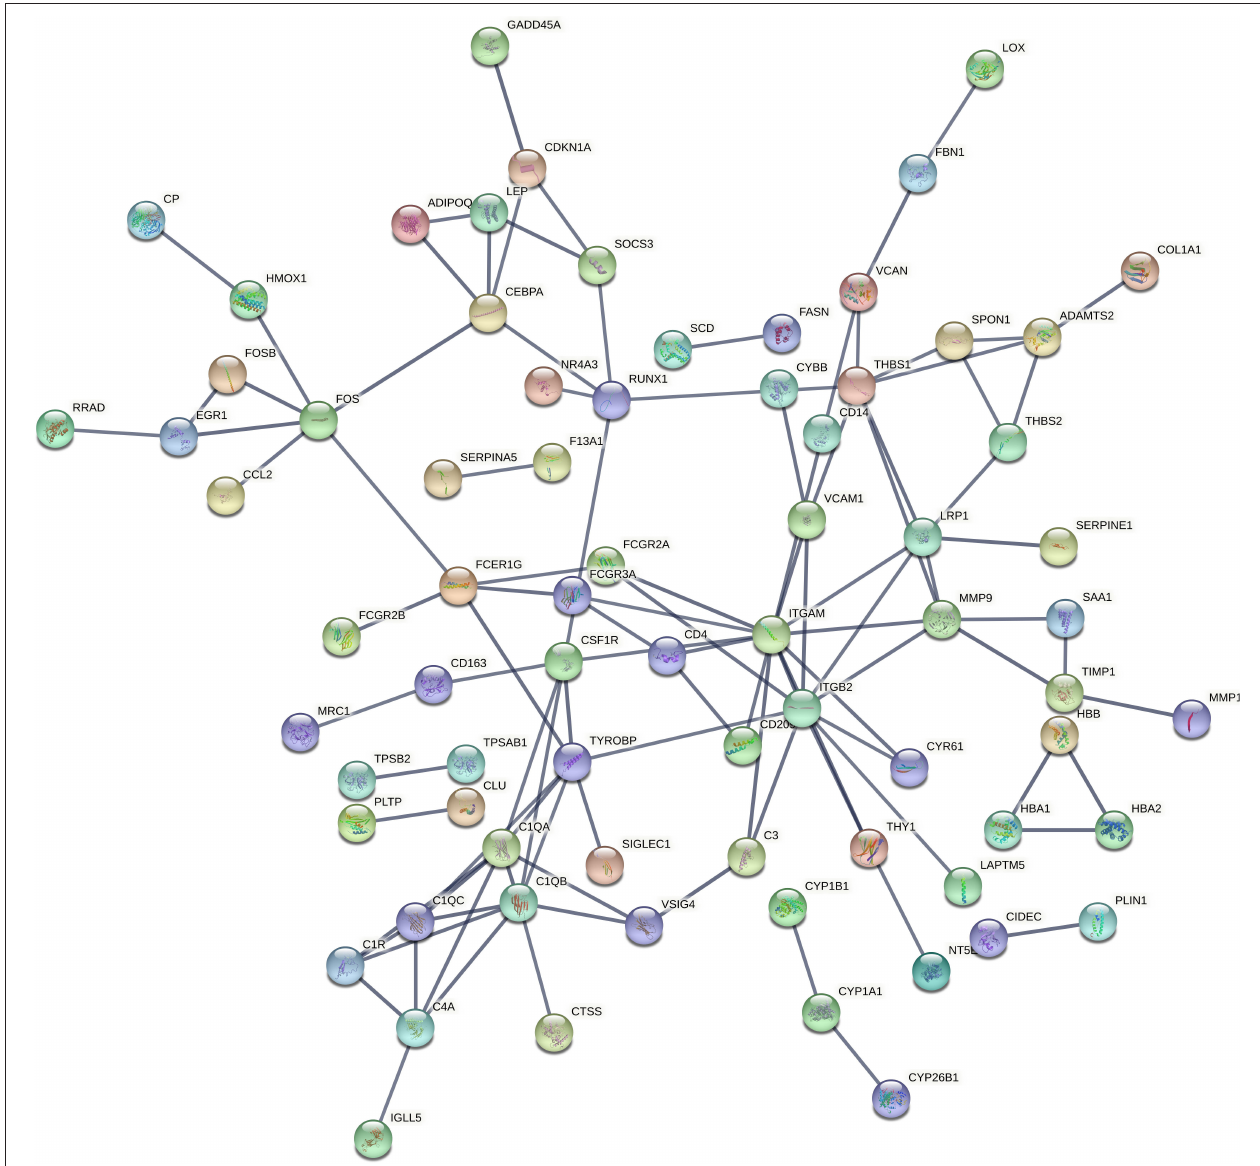
FIGURE 3 | PPI network of DEGs constructed by the STRING. PPI, protein–protein interaction; DEG, differentially expressed genes; STRING, Search Tool for the Retrieval of Interacting